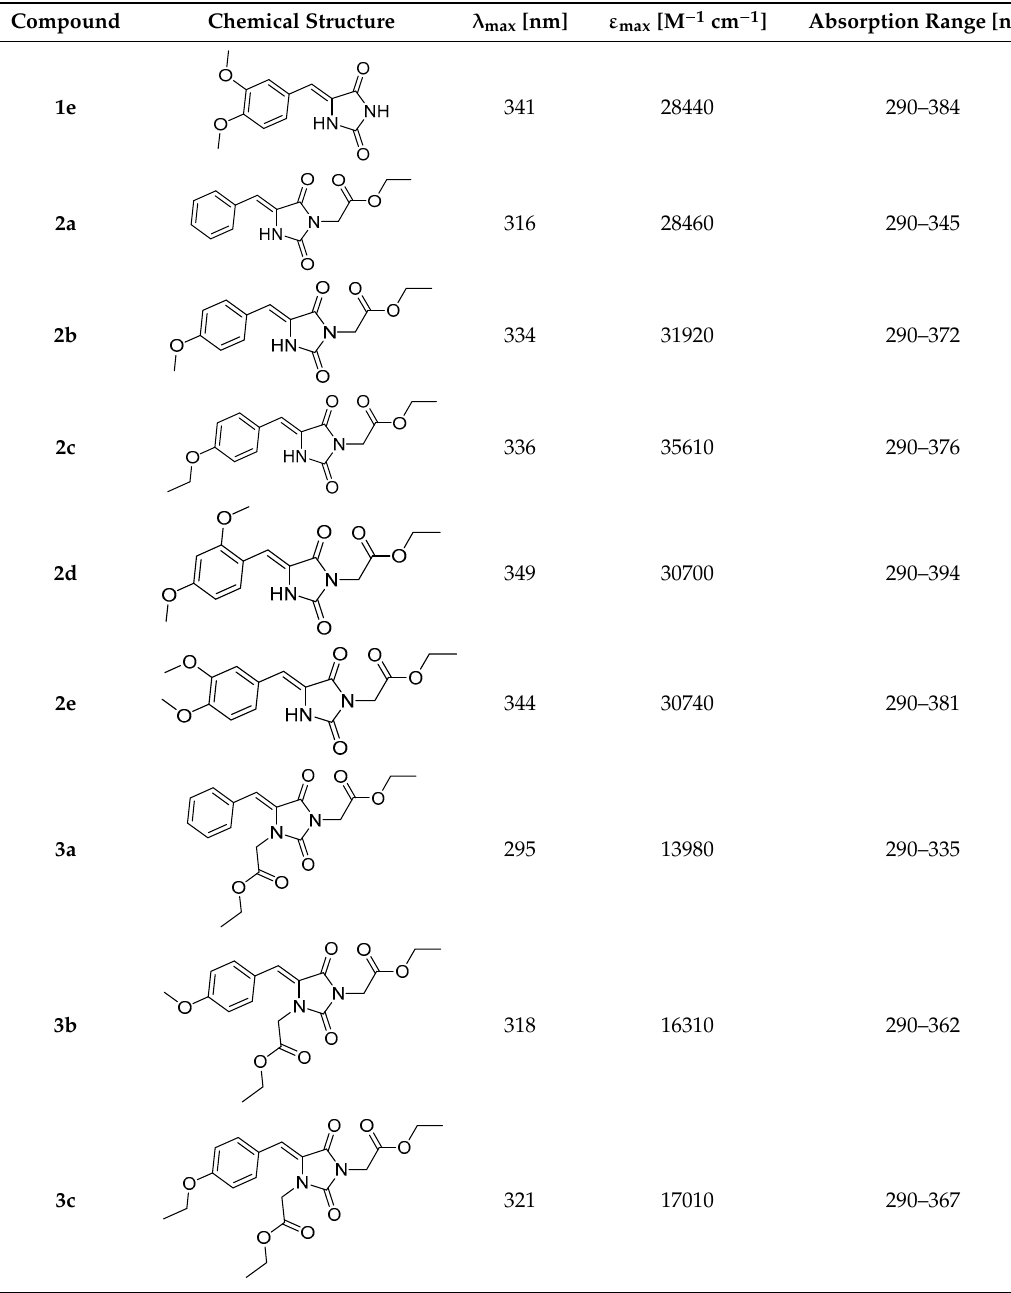
Table 1. Ultraviolet spectroscopic properties of the tested 5-arylideneimidazolidine-2,4-dione derivatives and reference UV filters obtained in methanol solutions. Compound